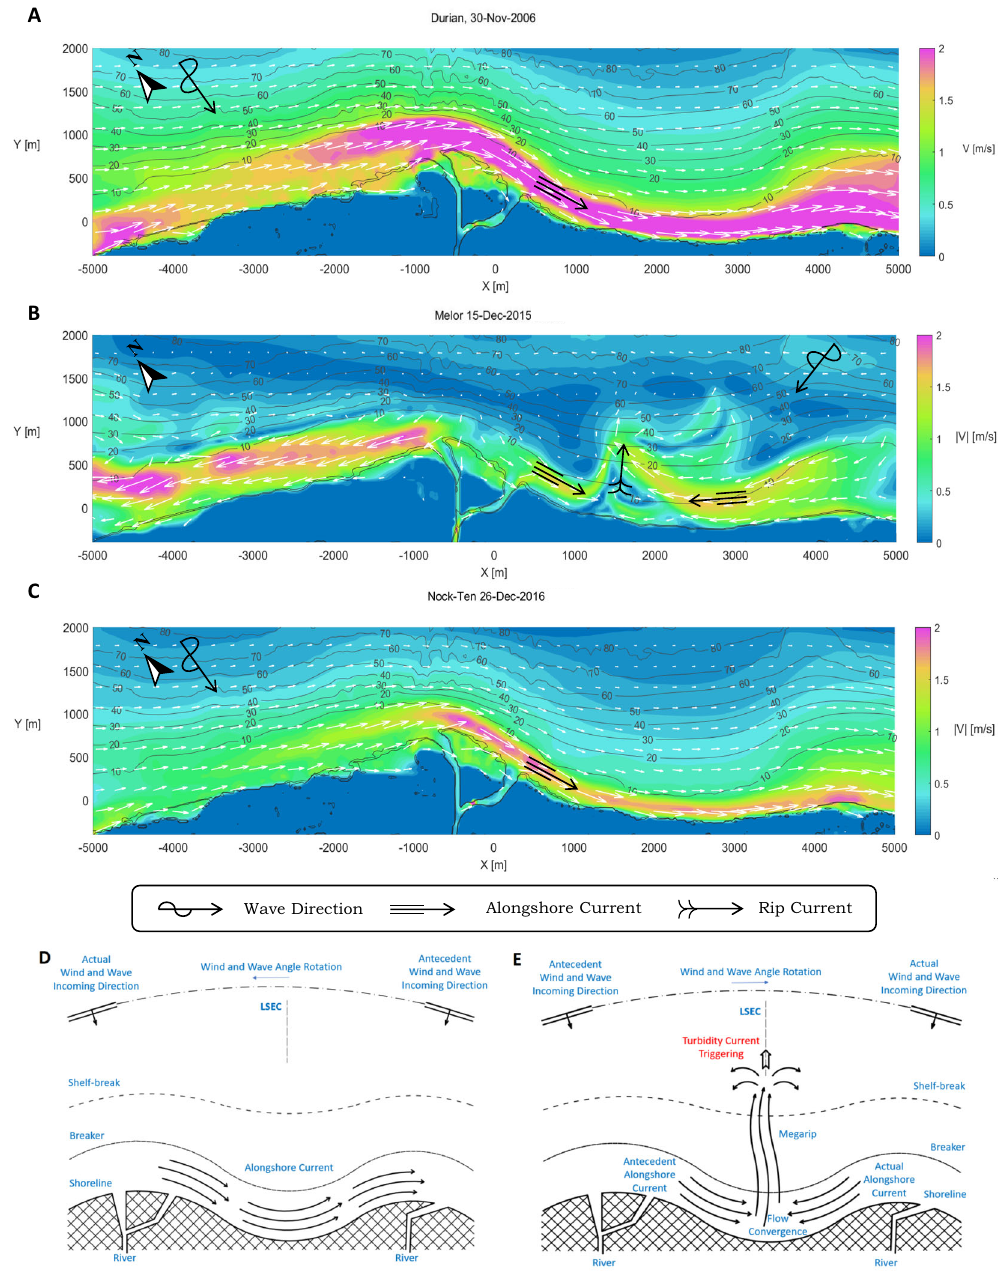
Fig. 4 Typhoon-induced coastal circulation patterns off the MT delta. Simulated fl ow conditions during the storm peaks induced by a Durian, b Melor and c Nock-Ten. Schematics of coastal circulation patterns: d alongshore currents during Durian ( a ) and Nock-Ten ( c ) not exhibiting any fl ow convergence at peak conditions; e convergence of opposite alongshore currents during Melor ( b ) generating the megarip that triggers the turbidity current in the